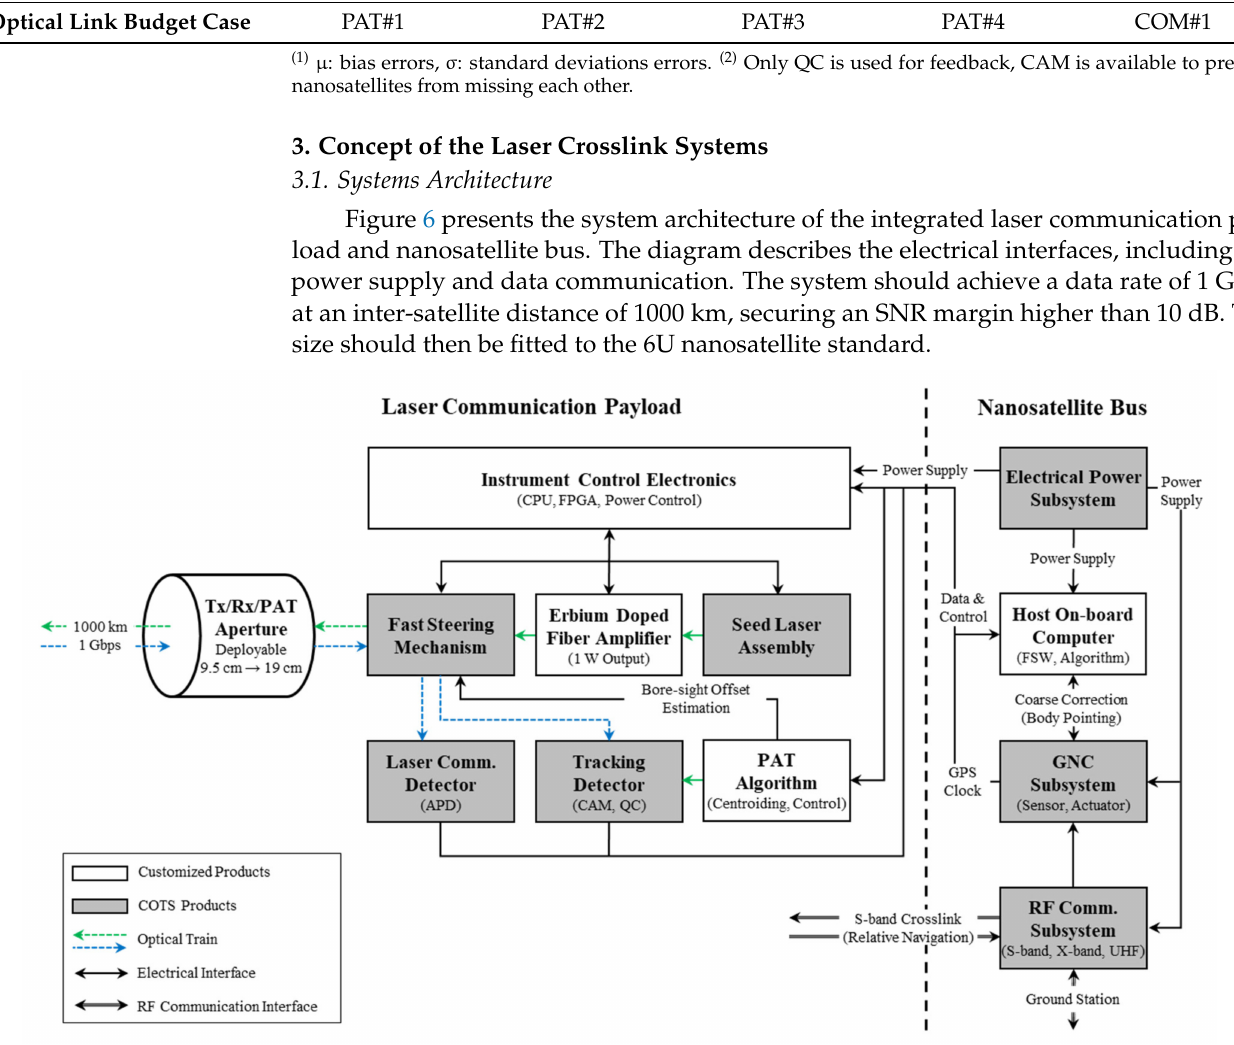
Figure 6. Diagram of the integrated laser communication payload and nanosatellite bus systems